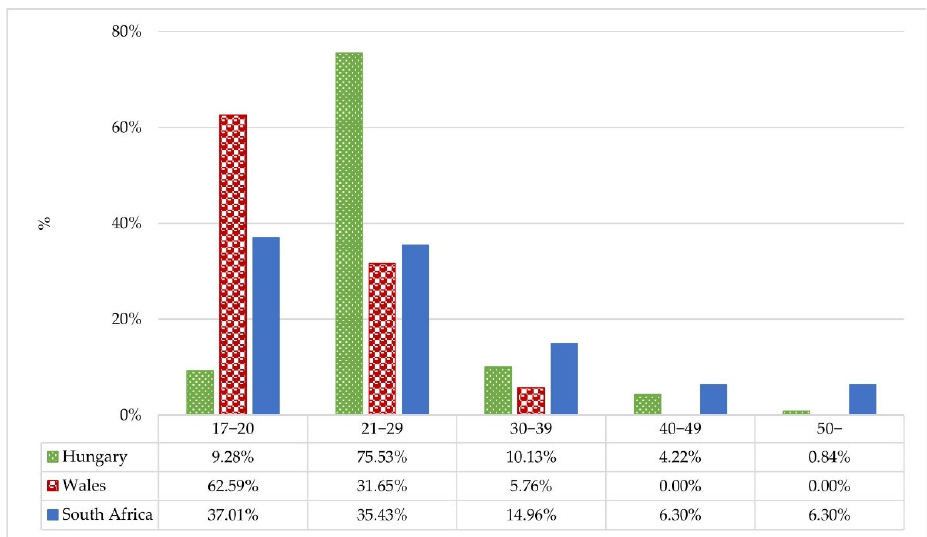
Figure 12. Participating students by age and country. More males (54%) than females (45%) completed the questionnaire. The participating students were from 46 different countries spread over four continents. Africa (Angola,